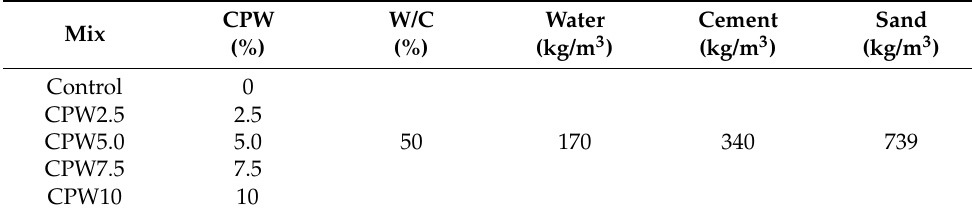
Table 2. Samples and their mix proportions used in this